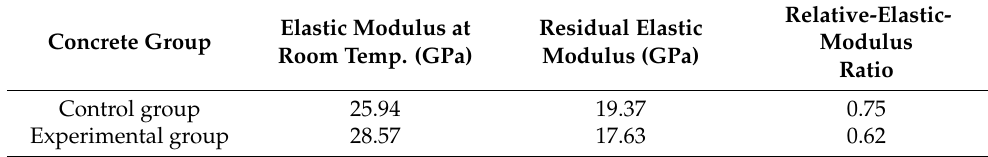
Table 10. Relative-elastic-modulus ratio of the compressive failure specimen after self-healing.